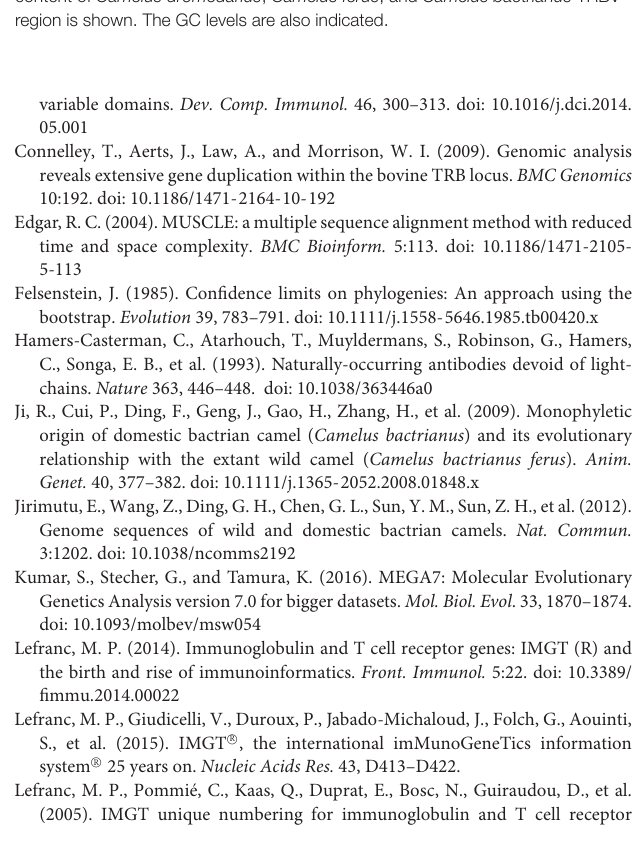
TABLE S5 | Description of the unrelated TRB genes in the Camelus bactrianus genome. The position of all genes and their classification are also reported. TABLE S6 | GEDI ID of the genes used in the phylogenetic analysis. TABLE S7 | Description of Camfer and Cambac TRBV ORF and pseudogenes TABLE S8 | Output file of the program RepeatMasker. Summary of the repeat content of Camelus dromedarius , Camelus ferus , and Camelus bactrianus TRBV region is shown. The GC levels are also